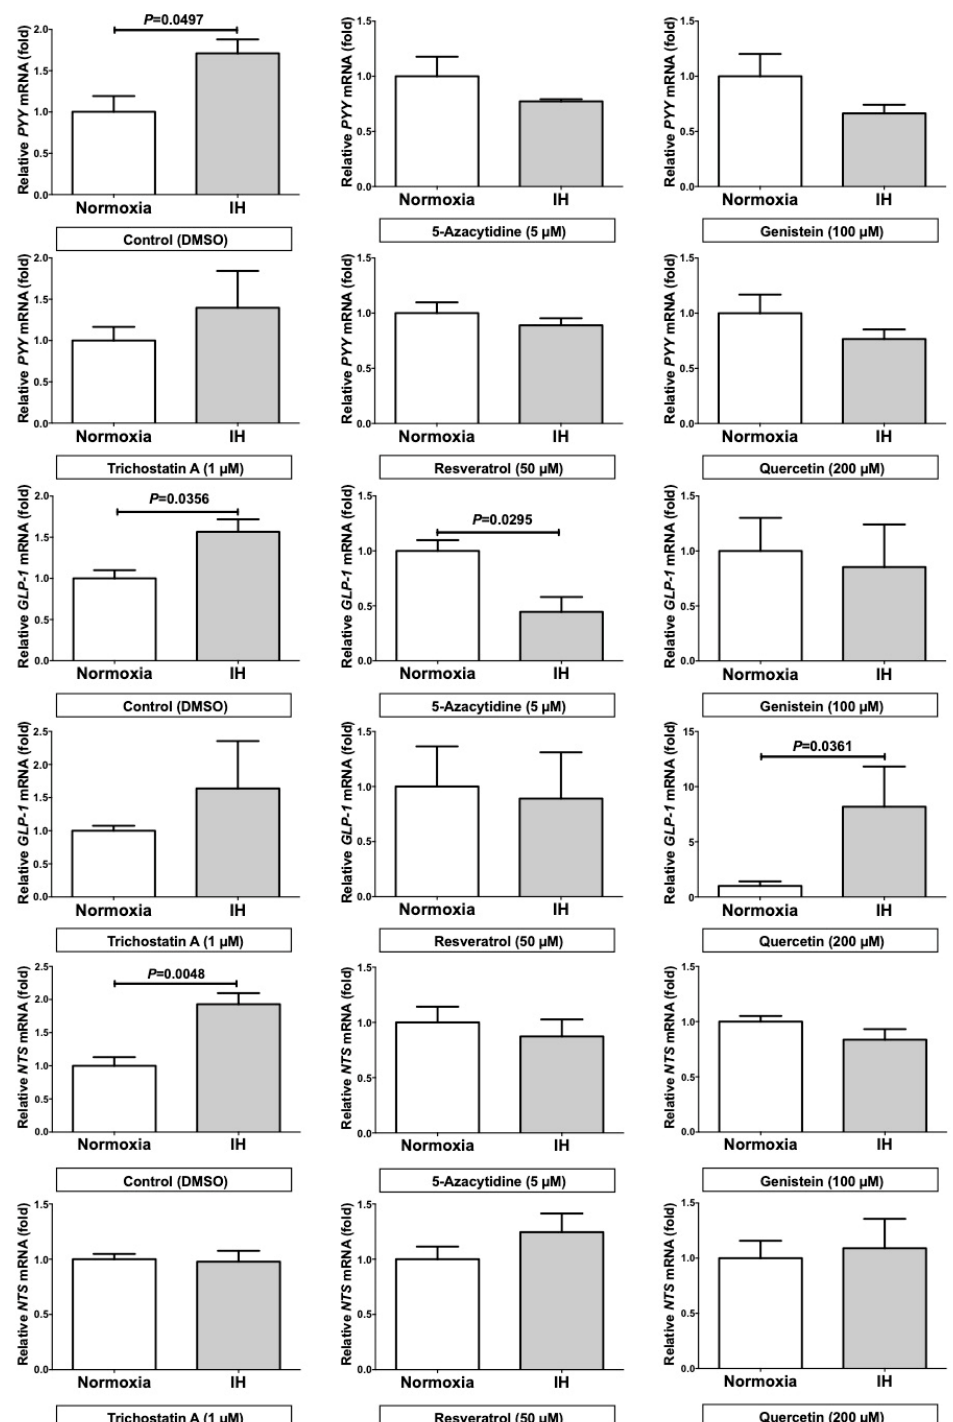
Figure 5. The mRNA levels of PYY , GLP-1 , and NTS in Caco-2 cells treated with normoxia or IH under the addition of epigenetic regulators. The addition of the epigenetic regulators abolished the IH-induced up-regulation of PYY , GLP-1 , and NTS mRNAs in Caco-2 cells. All data are expressed as the mean ± SE for each group ( n = 3–4). The statistical analyses were performed using Student’s t